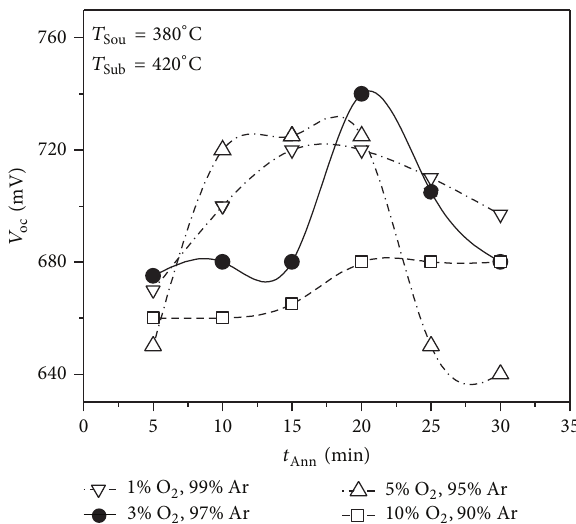
Figure 4: Thermal treatment in CdCl 2 vapor of the CdTe/CdS/CIO/glass part of the cell. Data of 𝑉 partial pressure used in the CSS-CdTe layers growth and for ) in the interval 5–30 min. 𝑇 annealing times ( 𝑡 Ann 𝑇 = 420 ∘ C were kept constant. Lines joining the experimental Sub points were outlined only as visual effect.